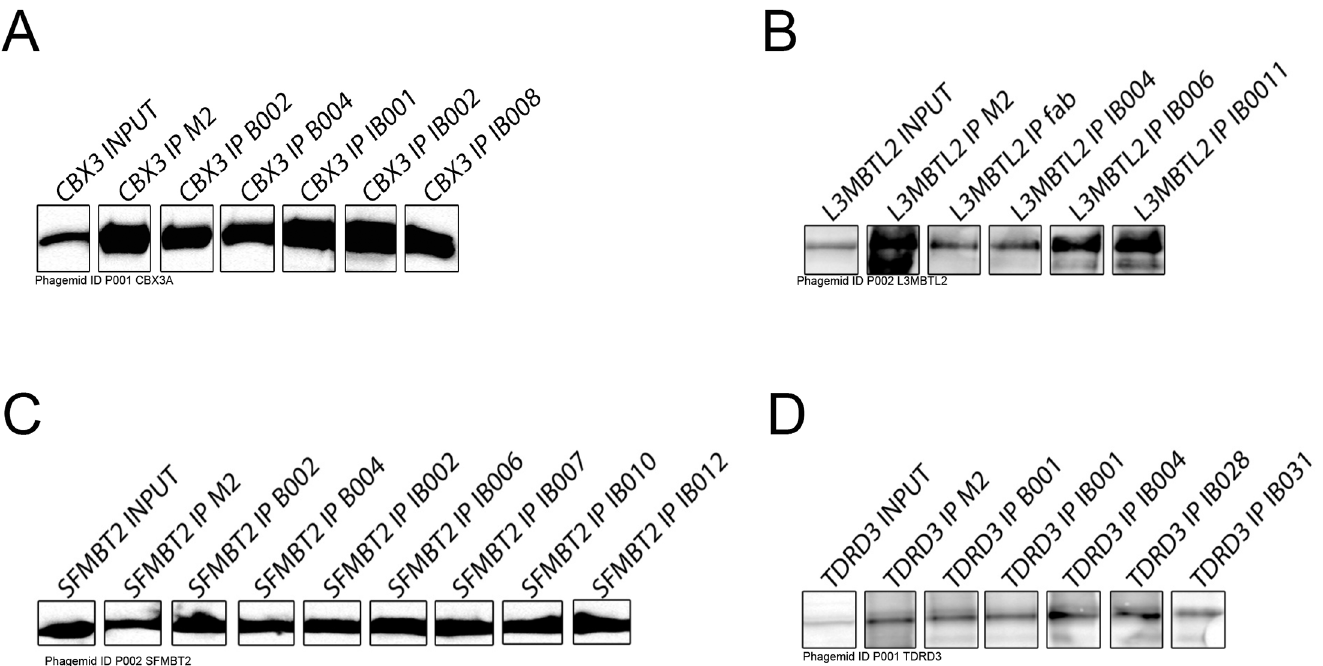
Fig 3. Performance consistency among Fabs and IgGs generated against the same target. Multiple Fabs and IgGs against several targets were used to immunoprecipitate their corresponding FLAG-tagged antigens. Western blot was performed and the presence of the FLAG-tagged immunoprecipitated protein was detected with an antibody against the tag. A) CBX3. B) L3MBTl2, C) SFMBT2, D) TDRD3. FLAG-tagged GFP was used as control (data not shown). Fab batches are labeled with a trailer “ -Bxxx ” and IgG batches are labeled with a trailer “ -IBxxx ” . Fabs against CBX3 and SFMBT2 have been produced twice (CBX3 (B002, B004); SFMBT2 (B002, B004)) while Fabs against L3MBTL2 and TDRD3 have been produced only once (L3MBTL2 (B001); TDRD3 (B001)). Multiple IgGs have been produced with corresponding IB numbers. Fabs/IgGs derived from the same phagemid clone have similar efficiencies and show a high lot-to-lot consistency.